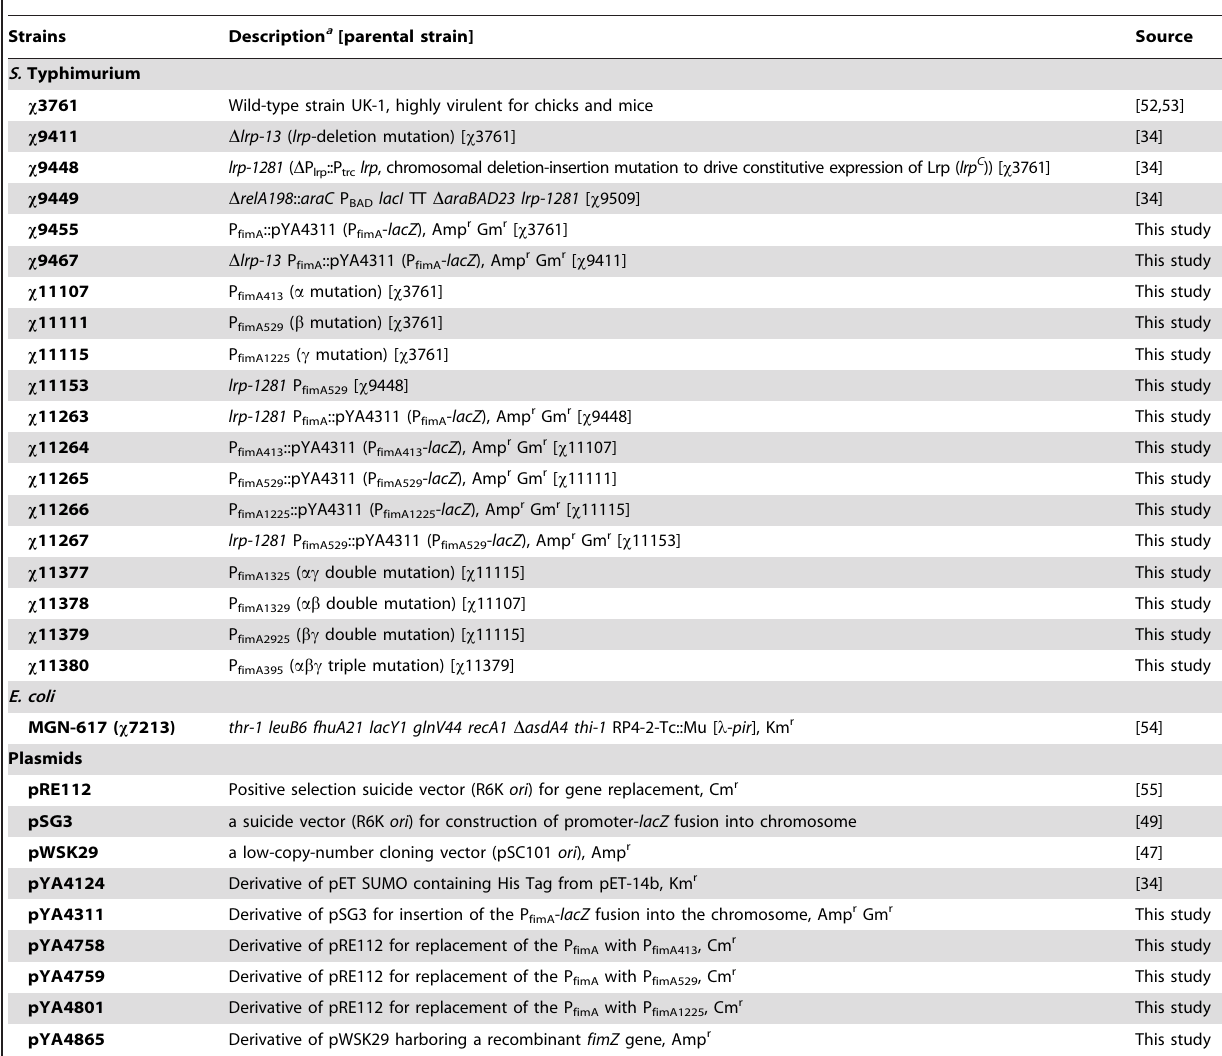
Table 1. Bacterial strains and plasmids used in this